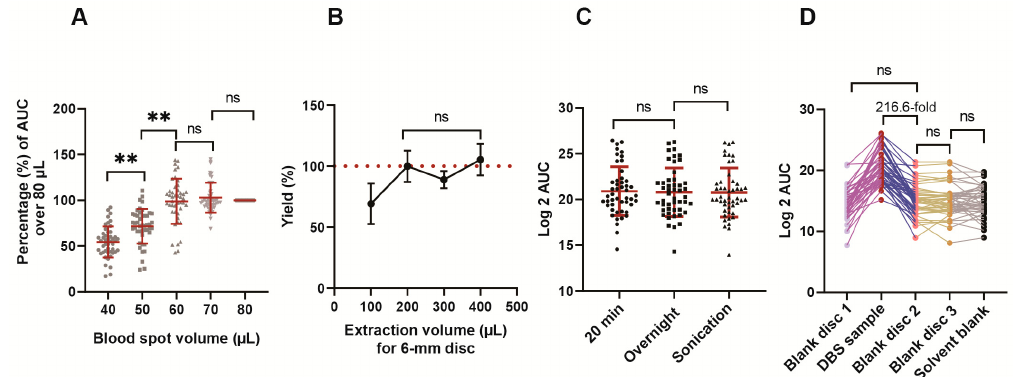
Figure 2. Dried blood spot (DBS) workflow optimization. ( A ) The e ff ect of blood spot volumes. ( B ) The e ff ect of the volumes of the extraction bu ff er. ( C ) The di ff erent extraction methods. ( D ) The e ff ect of cross-contamination between punches. A total of 47 representative metabolites covering the whole gradient were selected for the analysis. Data were mean ± SD. One-way ANOVA followed by Tukey’s test was used. ** p < 0.01 and ns indicated